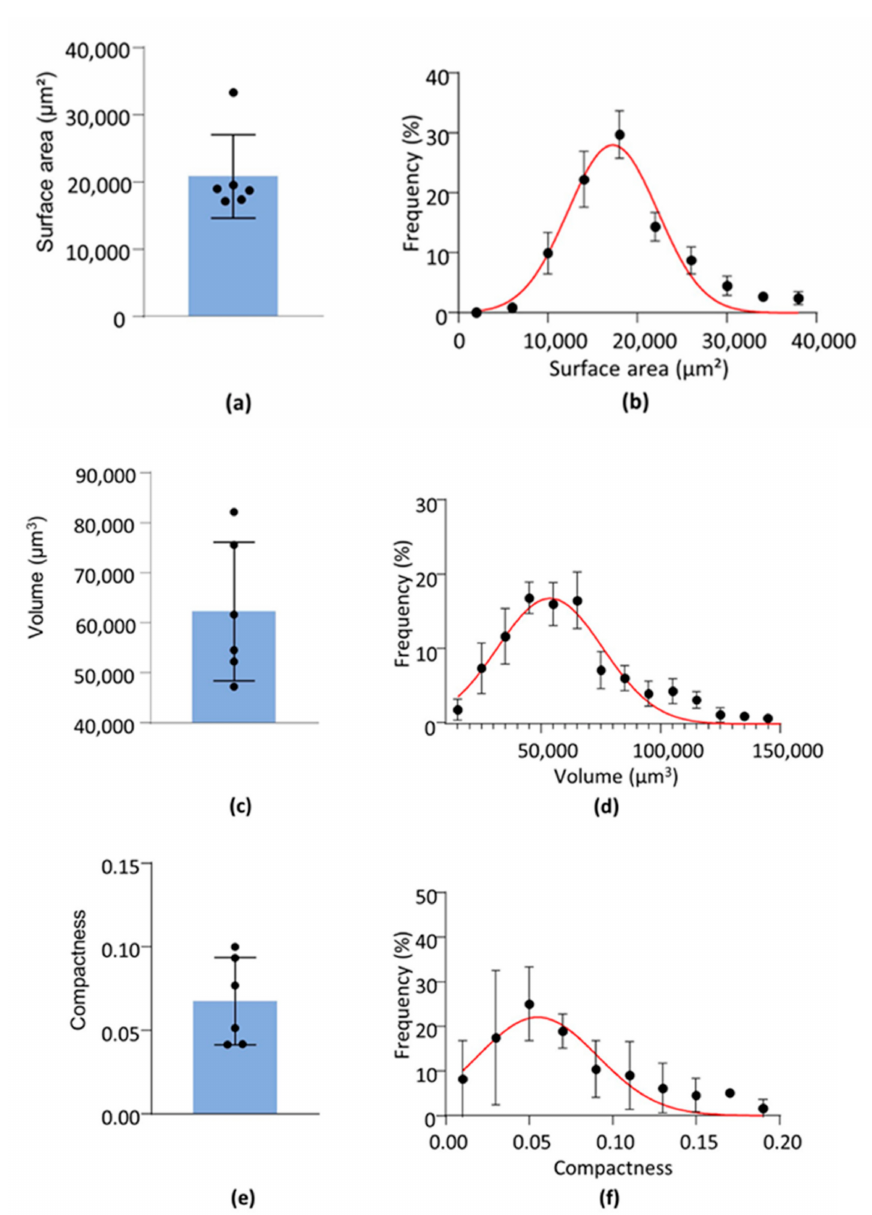
Figure 4. Glomerular surface area, volume and compactness ( a , c , e ). Mean glomerular surface area in µ m 2 ( a ), mean glomerular volume in µ m 3 ( c ), and mean glomerular compactness ( e ). Each dot corresponds to one sample value ( n = 6). Blue columns are mean values. Error bars represent SD ( b , d , f ). Relative frequency distribution of individual glomerular surface area ( b ), volume ( d ), and compactness ( f ). Dots and error bars represent the mean and SEM. Red curves are Gaussian fits of the parameter distribution (see Table